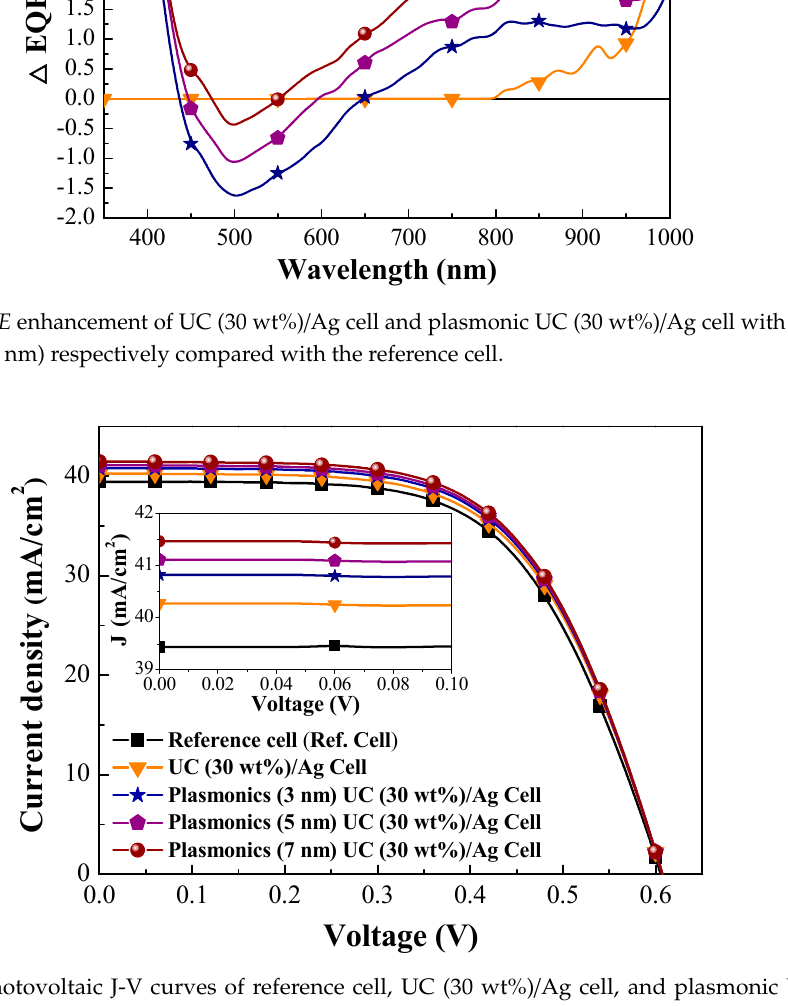
Figure 16. Photovoltaic J-V curves of reference cell, UC (30 wt%) / Ag cell, and plasmonic UC (30 wt%) / Ag cells with In NPs (3 nm, 5 nm, 7 nm).